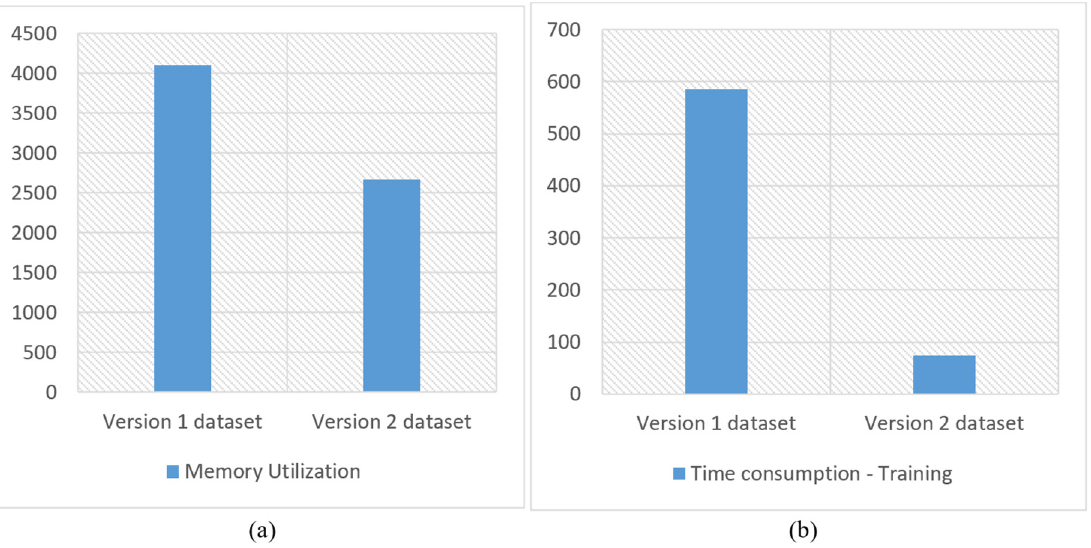
Figure 16. Memory utilization ( a ) and training time ( b ) of the SVM with the RBF kernel on versions 1 and 2 of the datasets.